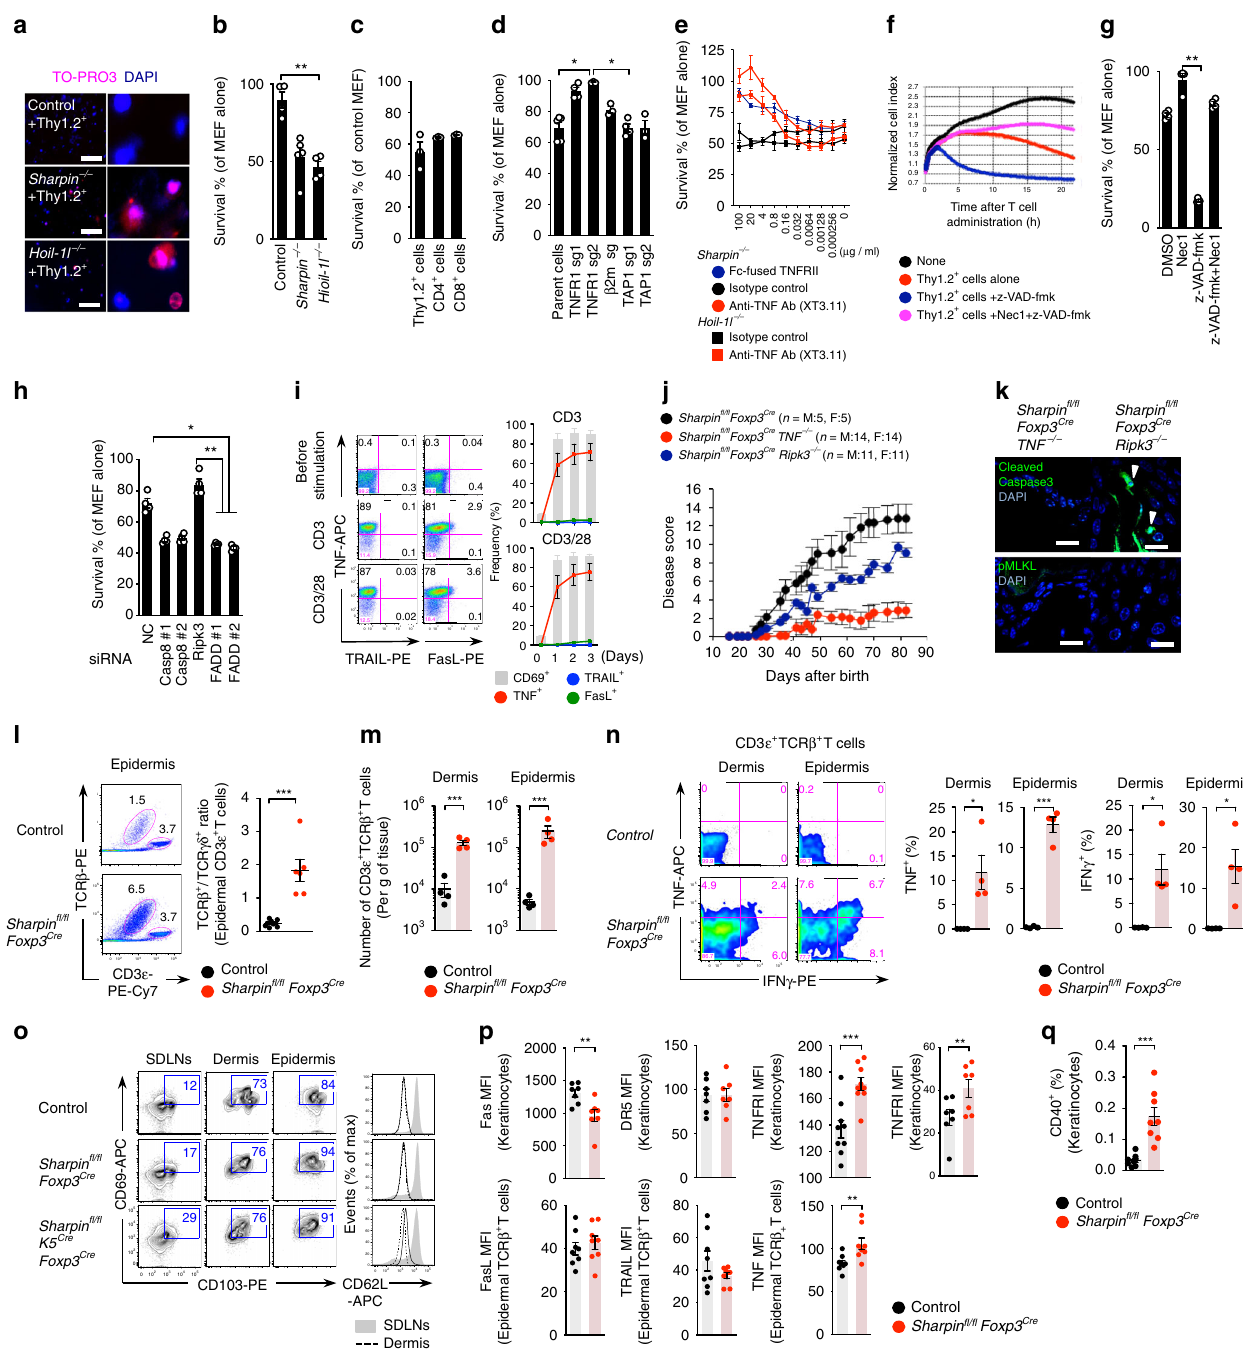
Fig. 6 A pathogenic role of the TNF α -TNFRI axis during T cell-mediated autoin fl ammation. a Staining of MEFs co-cultured with T cells. Scale bars: 100 μ m. Magni fi ed images are shown on the right. b – d Percentage of surviving cells in a ( b ), Sharpin − / − MEFs co-cultured with the indicated T cells ( c ), and the indicated CRISPR/Cas9-targeted MEFs ( d ) n = 4 biologically independent experiments. e Treatment with a TNF α -neutralizing antibody or solubilized TNFRII. f Treatment with z-VAD-fmk and/or Nec1. The iCelligence system was used to measure cell viability. g , h Survival after 10 h of the treatment described in f ( g ) or after siRNA knockdown ( h ). n = 4 independent experiments. i Expression of the indicated receptors on the T cell surface after TCR stimulation. j Disease progression among the indicated strains. M, Male; F, Female. k Immuno fl uorescence staining of skin sections. Scale bars: 20 μ m. l Ratio of CD3 ε int TCR β + :CD3 ε hi TCR γδ + cells. n = 6 biologically independent animals. m Number of TCR β + T cells in the skin. n = 4 biologically independent animals. n Percentage of TNF α - and/or IFN γ -expressing TCR β + T cells in the skin. n = 4 biologically independent animals. o Dot plots representing T RM cells. p , q MFI or percentage of cells expressing the indicated surface proteins. n = 8 biologically independent animals. Small horizontal lines indicate the mean (±s.e.m.). * p < 0.05, ** p < 0.01, *** p < 0.001. Kruskal – Wallis test with Bonferroni correction ( α value = 0.05) was used for b – d , g , and h , while two-tailed Mann – Whitney U-test was used for l – n , p , and q . Data are representative of at least two independent experiments ( a , f , i , k , o ), or pooled from three to six ( b – e , g , h , l – n , p , q ) independent experiments. Source data are provided in a Source Data fi le